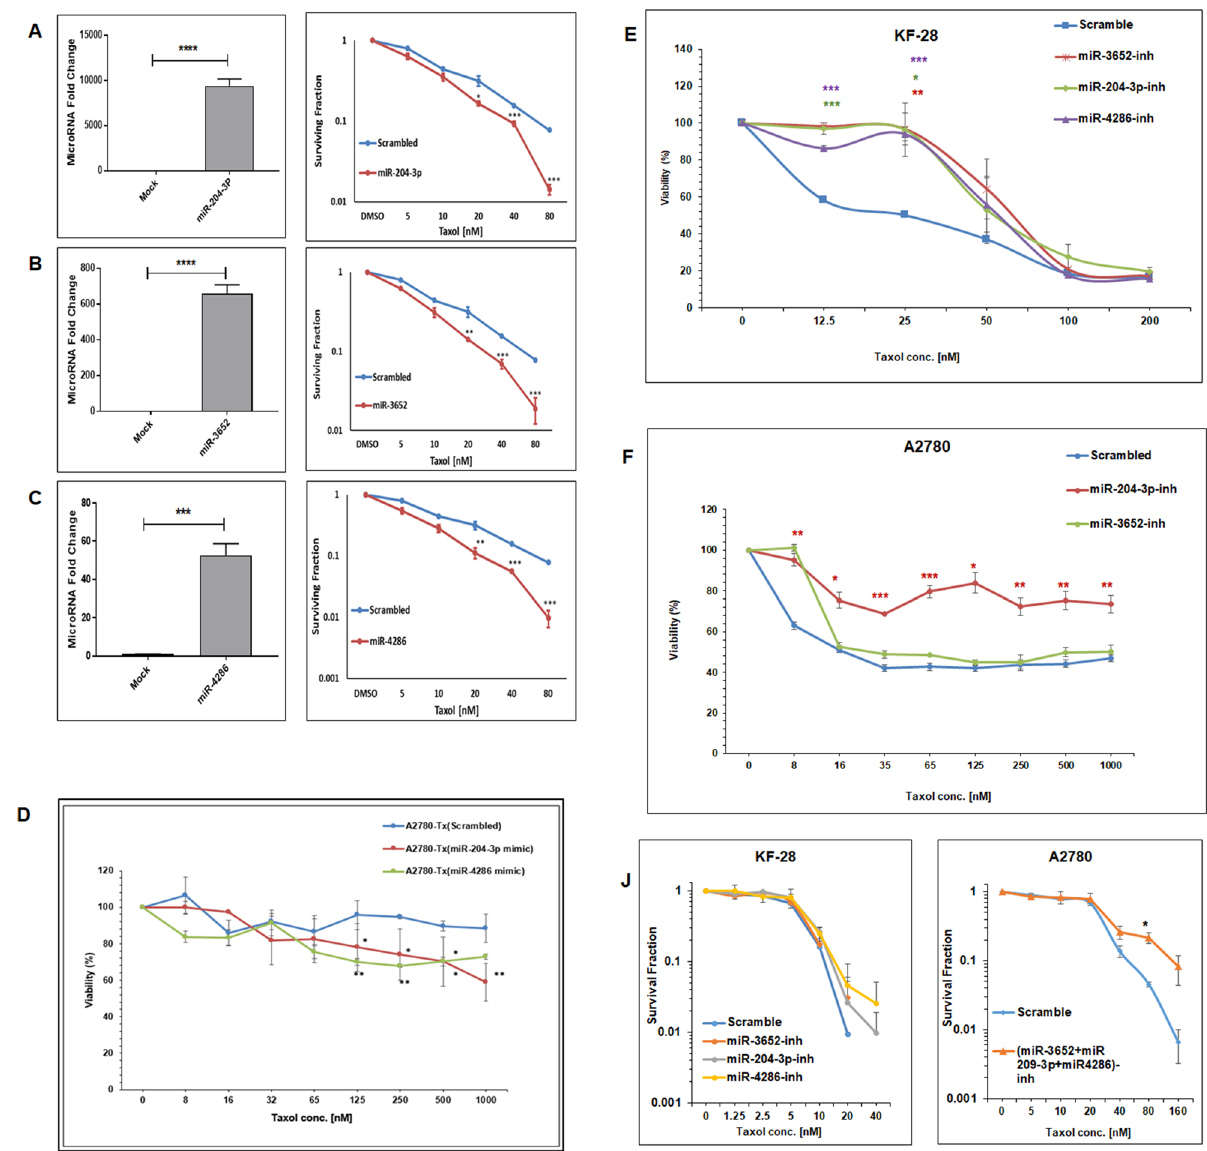
Figure 6. Overexpression of the epigenetically regulated miRNAs restors OC cells’ response to PTX. Quantitative PCR and c olony formation assay for KF-Tx cells transfected with ( A ) micoRNA-204-3p, ( B ) miRNA-3652, and ( C ) MiRNA-4286 mimics, respectively. The left panels are qPCR of each gene validating the over-expression while the left panels are colony forming ability results from each miRNA transfected or scrambeled. ( D ) Viability assay results from A2780-Tx cells after transfection of miRNA-204-3p, miRNA- 4286 mimics or scambled RNA, treated with the indicated concentrations of PTX. Viability of the KF-28 ( E ) and A2780 ( F ), treated with the indicated concentrations of PTX, after transfection with indicated miRNA inhibitor/s or scramble. ( J ) Clonogenic assay results of KF-28 cells transfected with the indicated miRNA inhibitor/s or scramble RNA followed by treatment with the indicated concentrations of PTX (left panel) while similar results from A2789 cells (right panel), as the cells were treated with PTX after transfection with the mixture of the indicated miRNAs inhibitors followed by PTX. Results are means ± SE from three independent experiments. One way analysis of variance (ANOVA) was performed to get the statistical significance of difference at each point (* p < 0.05, ** p < 0.01 and *** p <